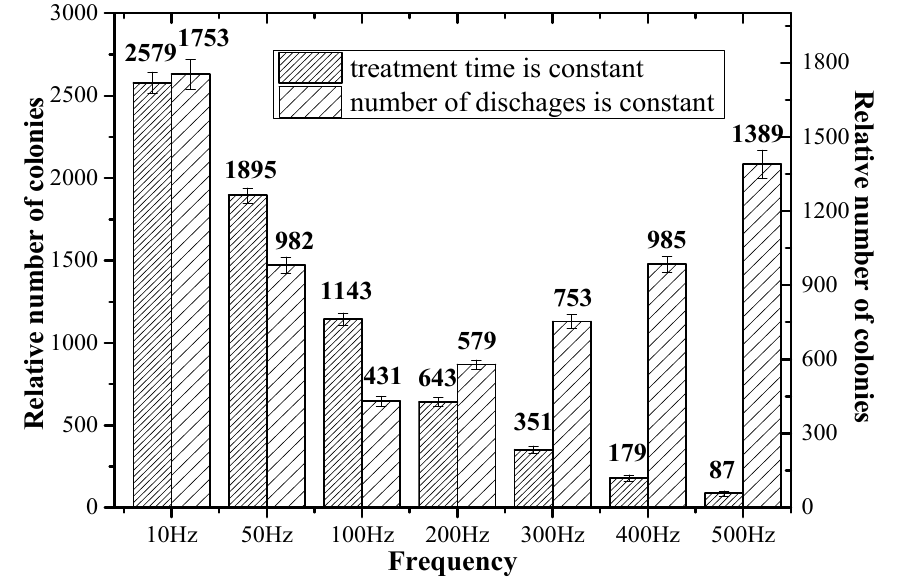
Figure 10. Relative numbers of the E. coli colonies with the PRF varied.